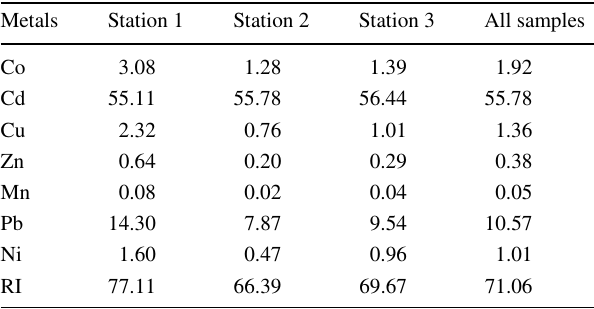
Table 4 Individual potential risks ( E i r ) and potential ecological